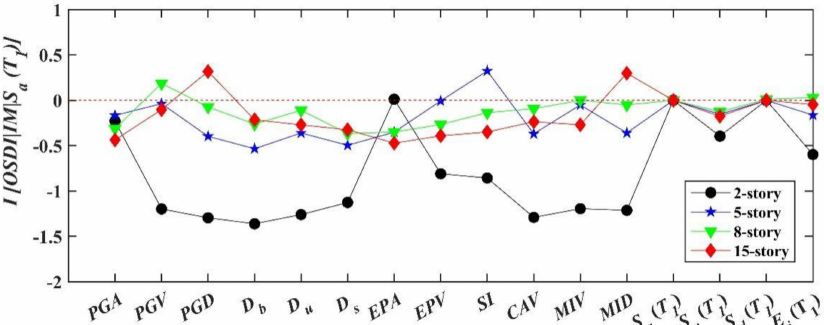
Figure 12. I ( IM 2 | IM 1 ) between IMs and OSDI , obtained via the cloud analysis of four typical structures subjected to pulse-like ground